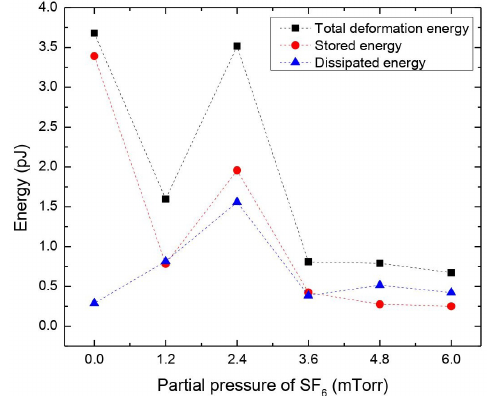
Figure 18. Total deformation, stored, and dissipated energy as a function of R . SF